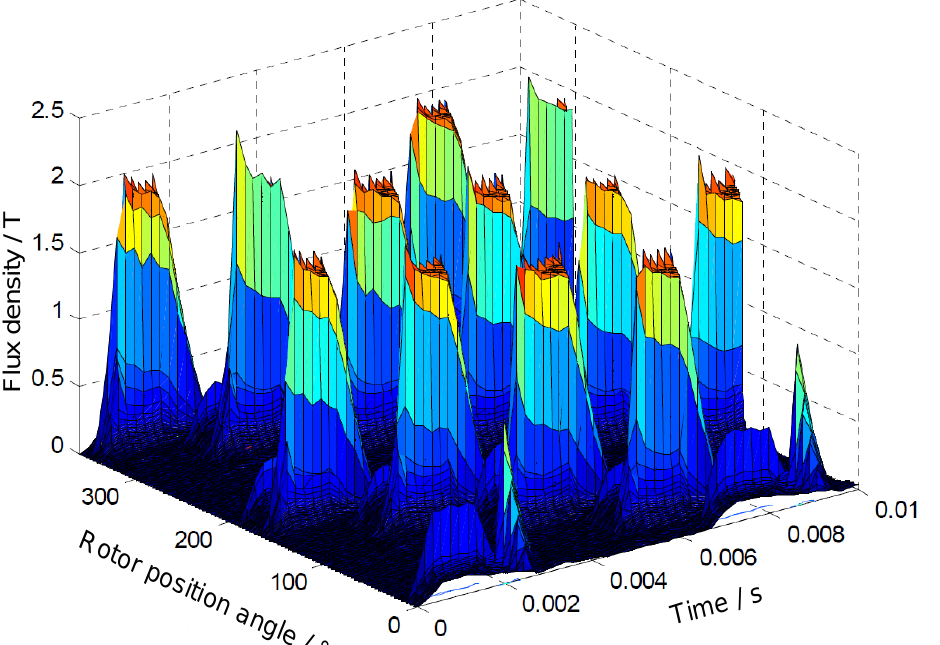
Figure 9. 3-D graph of flux density in the outer air gap.